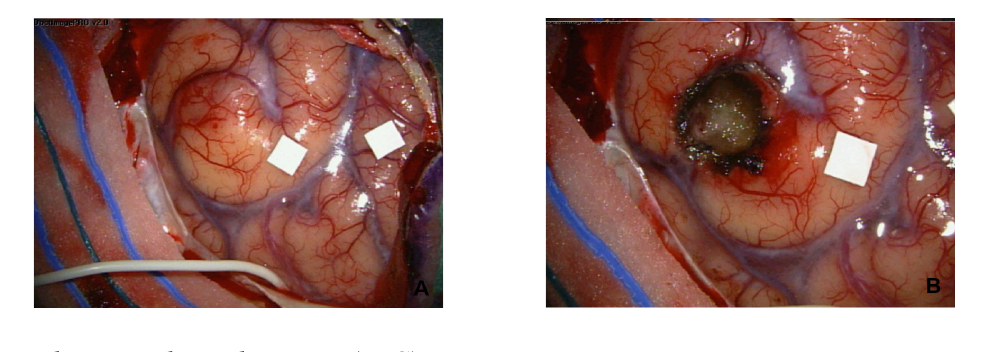
Figure 3. Macroscopic aspect of brain metastases from colorectal cancer before ( A ) and after ( B ) neurosurgical